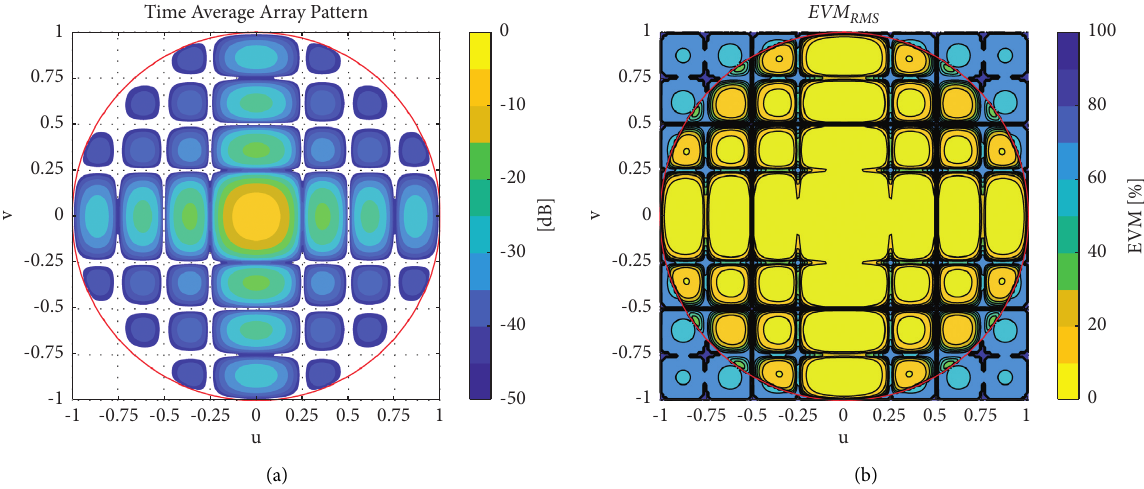
Figure 3: Regular (nonoutspacing) array performance: K � L � 8, d cos θ element power pattern is used. (a) Time average array pattern. (b)